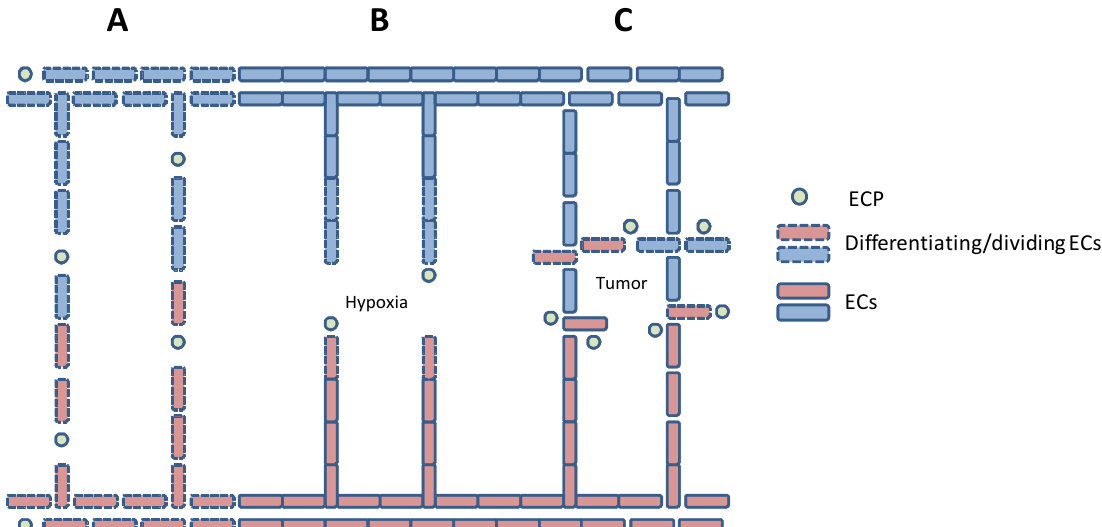
Figure 1. Schematic presentation of vasculogenesis ( A ), physiological angiogenesis ( B ) and tumor angiogenesis ( C